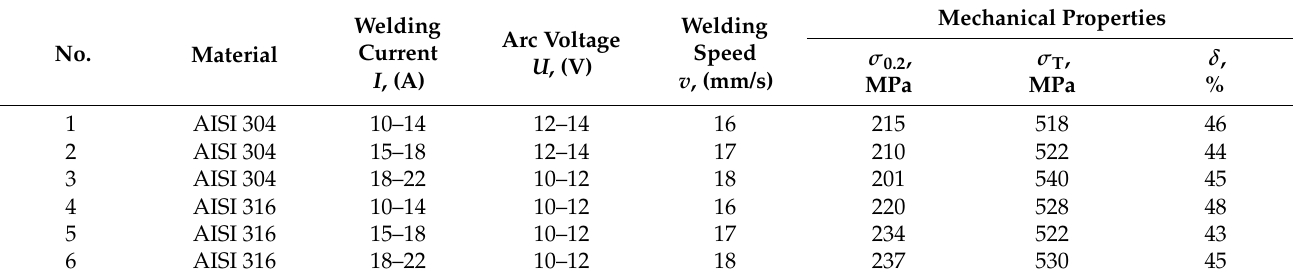
Table 1. Results of the mechanical